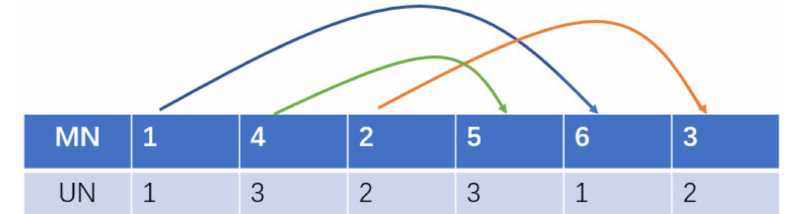
Figure 1. The hybrid coding